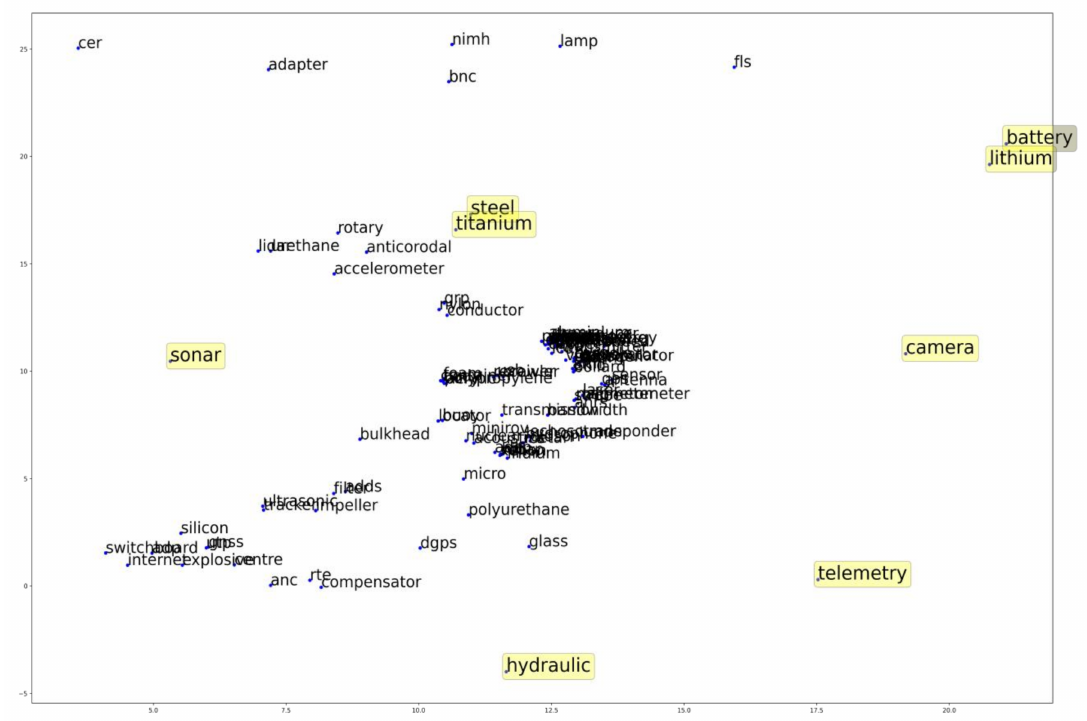
Figure 5. SGTM-based map for products.